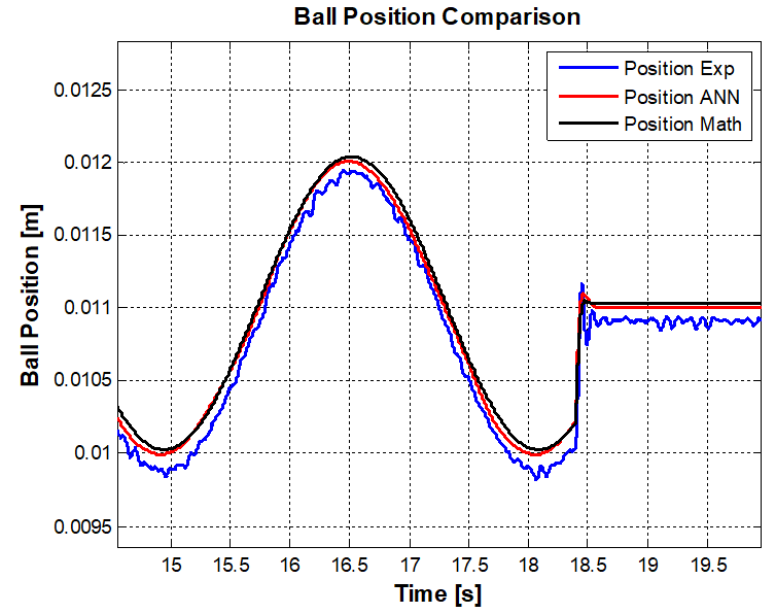
Figure 9. A comparison of ANN model performance and mathematical model performance.